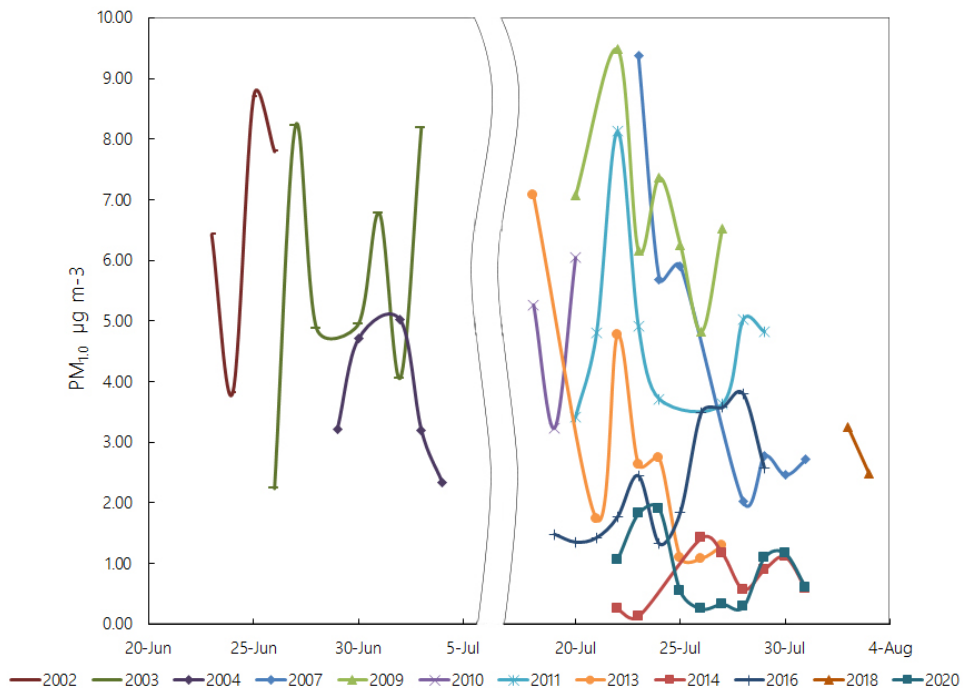
Figure 7. Daily mass concentration of PM 1.0 (according to LAS data. The optical aerosol particle size range in our study is close to size range of PM 1.0 ) for the entire observation period of 2002–2020.